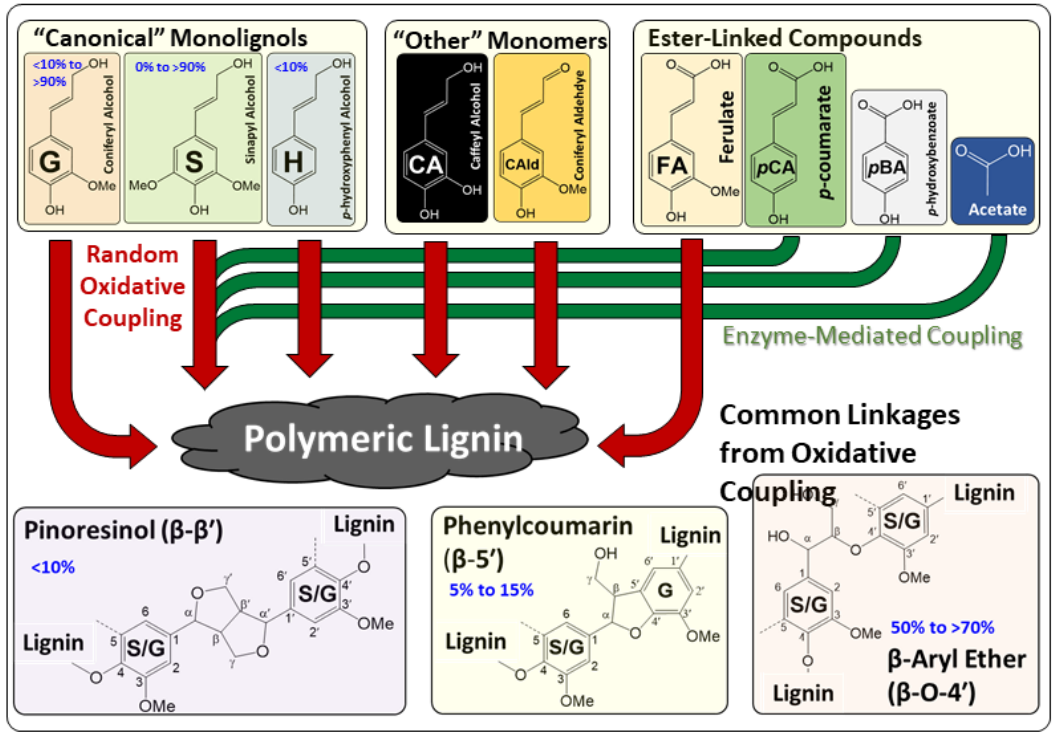
Figure 1. Key compositional and structural features of lignins arising from lignin biosynthesis.